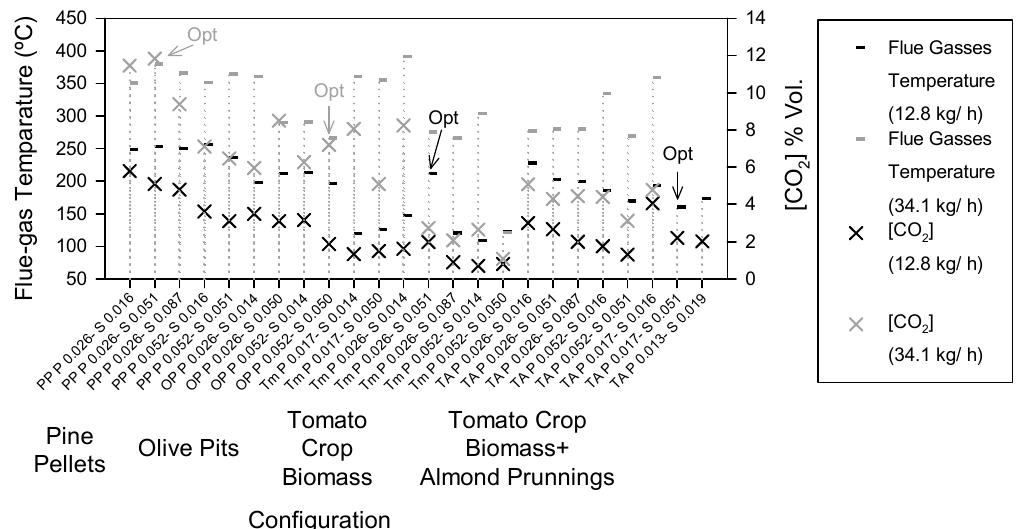
Figure 5. Flue-gas temperature and [CO 2 ] were recorded for each biomass type, their corresponding fuel inputs, and the primary and secondary air rates. (Opt: The configuration identified as optimum).